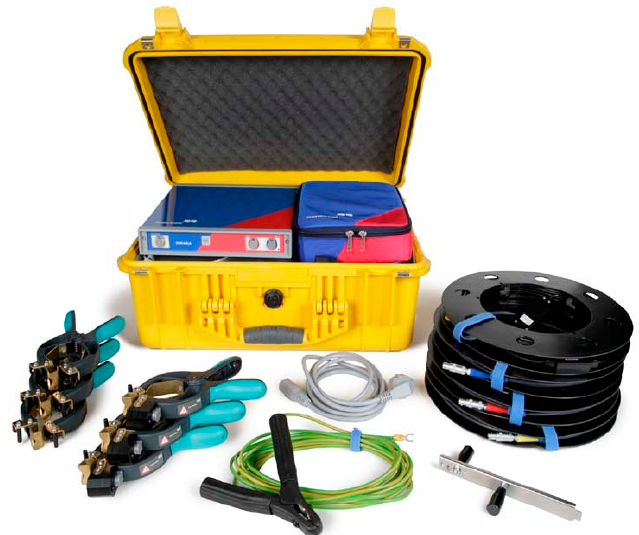
Figure 4. DIRANA.